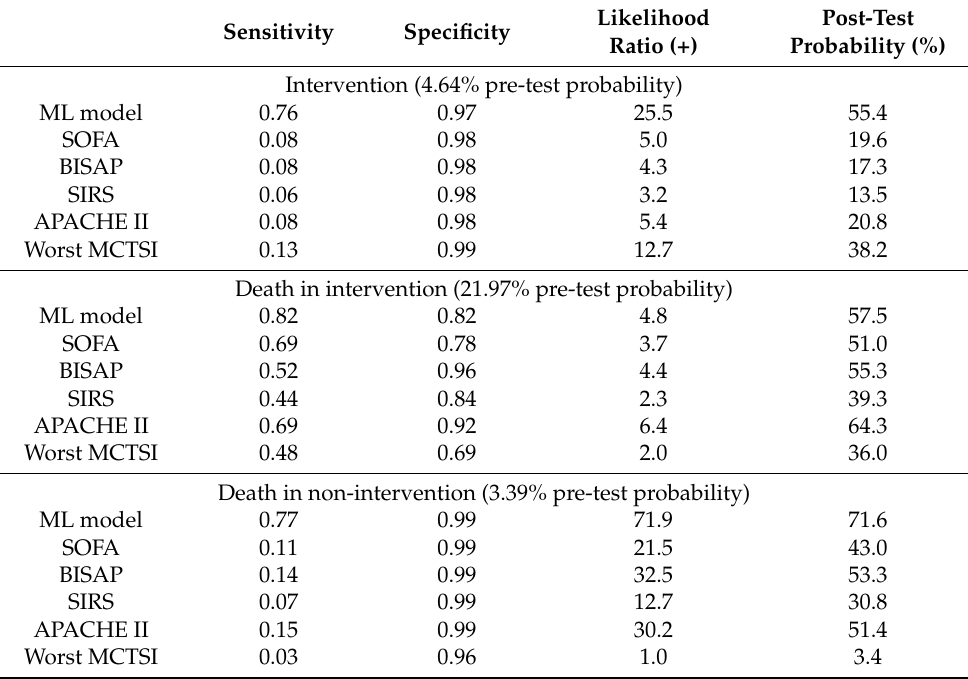
Table 4. Performance of prediction with ML models and clinical scoring systems in the test